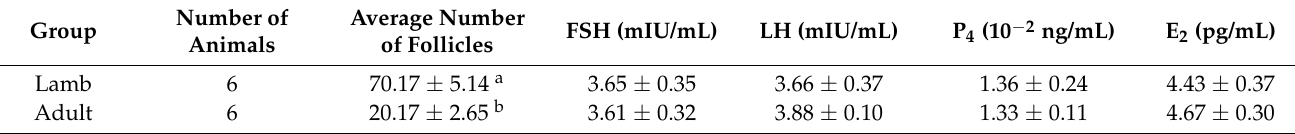
Table 1. Measurement of follicle numbers and serum hormone levels in lamb and adult